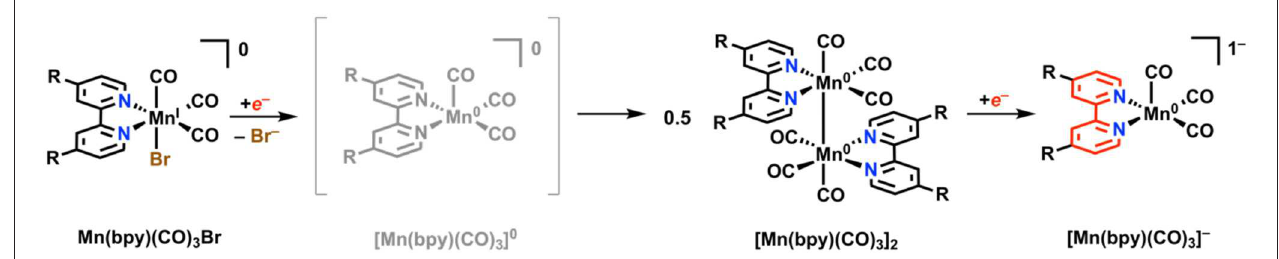
FIGURE 9 | Faradaic reduction mechanism of Mn(bpy)(CO) 3 X. Adapted with permission from Machan et al. (2014b). Copyright 2014 American Chemical